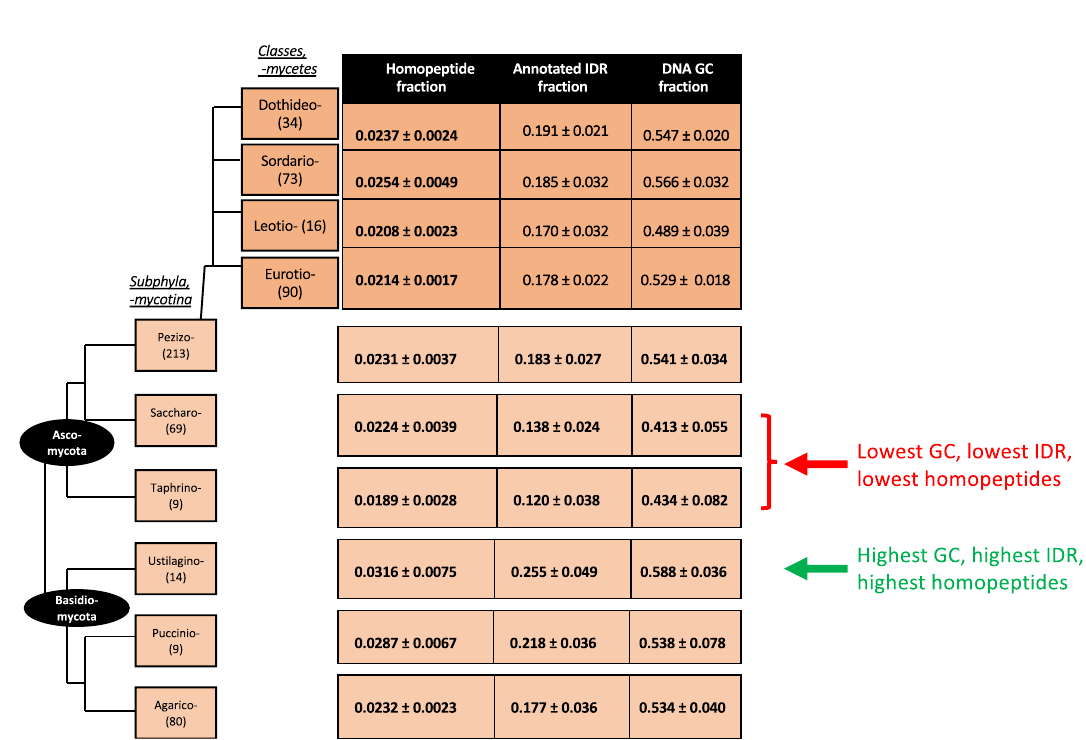
Figure 2. Schematic Dikarya phylogenetic tree with mean fractions of homopeptides, annotated IDRs and DNA GC content. The values for sub-phyla (clades suffixed ‘-mycotina’), and classes (suffixed ‘-mycetes’) within large subphylum Pezizomycotina are